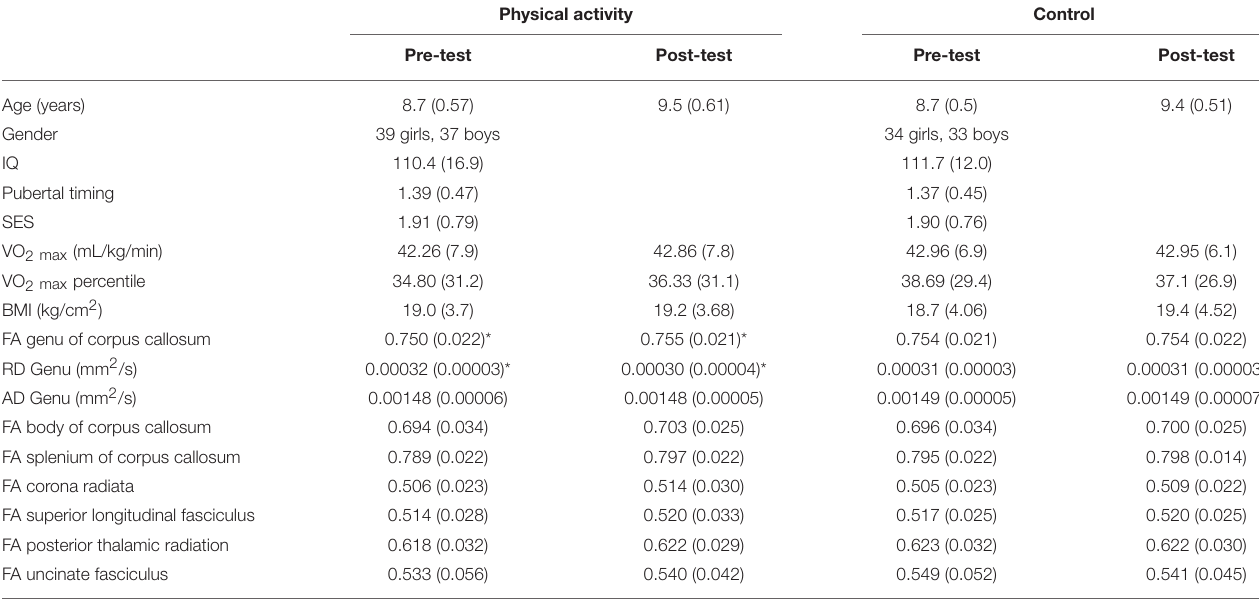
TABLE 1 | Mean ( SD ) for physical activity and wait list control groups at pre-test and